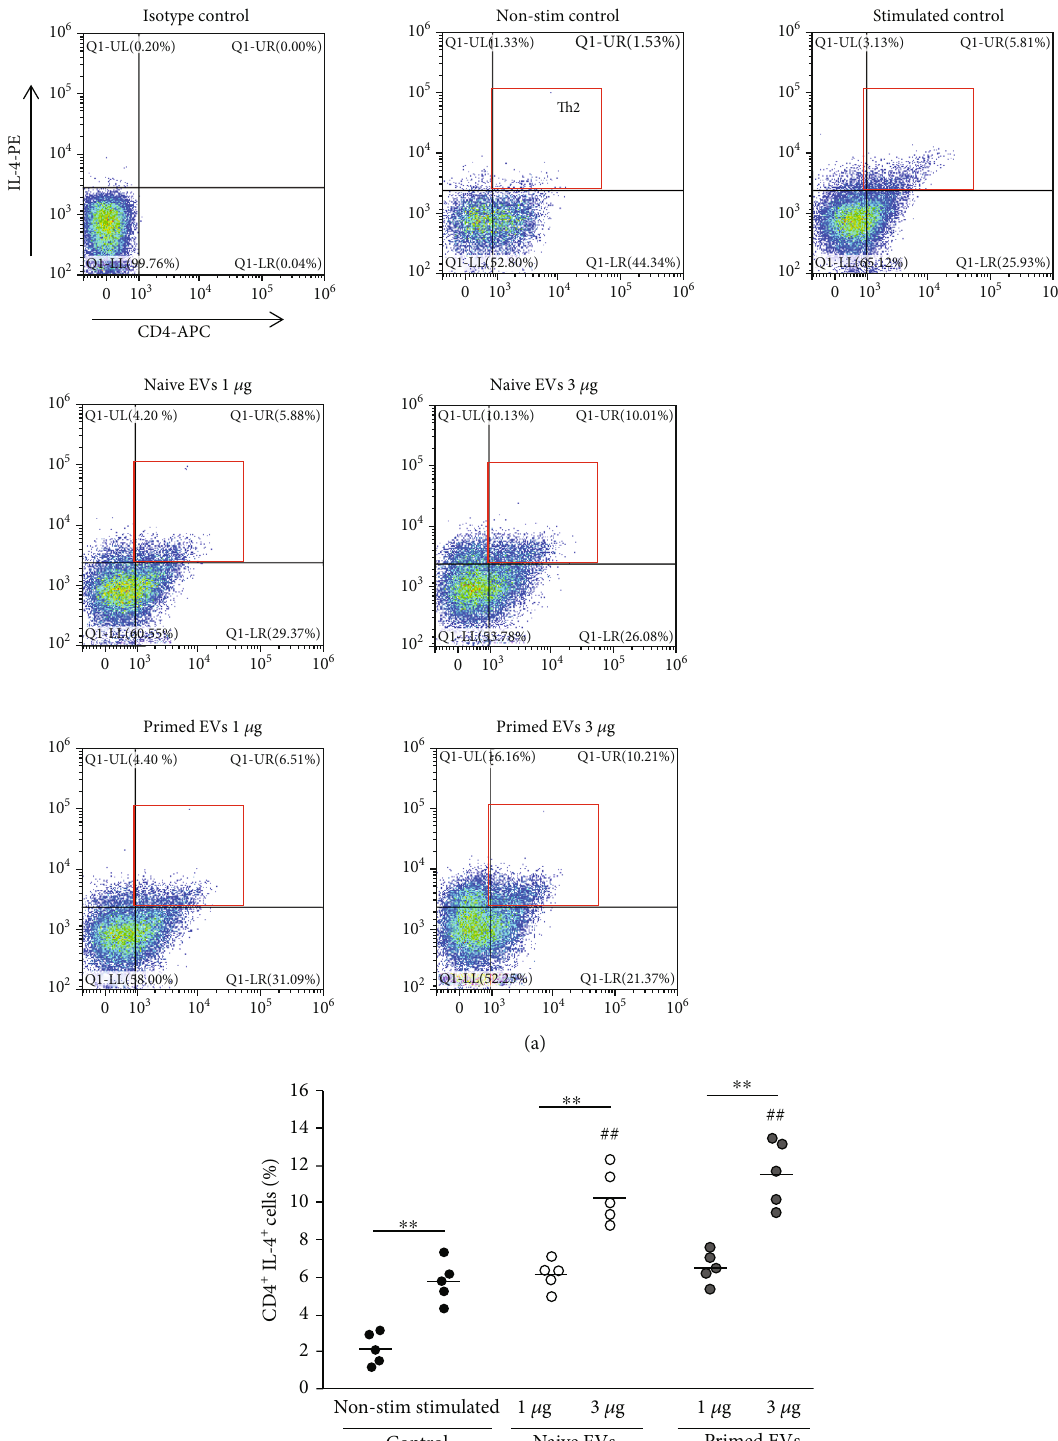
Figure 8: Di ff erentiation into Th2 cells after coculture of PBMCs with cADSC-EVs. (a) Flow cytometric detection of CD4 + IL-4 + cells among CD3 + T cells (gated in red square). Non-stim control: PBMCs that were not stimulated with PMA and ionomycin. Stimulated control: PBMCs after coculture with cADSC-EVs and stimulated by PMA and ionomycin. (b) Comparison of CD4 + IL-4 + cells among CD3 + T cells after coculture of PBMCs with various concentrations (1 or 3 μ g/ml) of naive or primed cADSC-EVs. The ratio of Th2 cells was not di ff erent between naive and primed EVs at the same concentrations. The solid line indicates the average. ## P < 0 : 01 vs. stimulated control. ∗∗ P < 0 : 01 , between